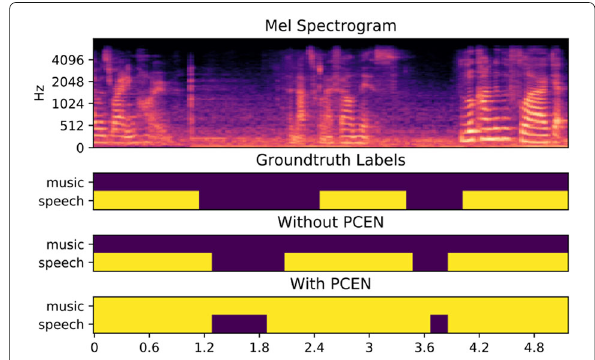
Fig. 4 An example selected from TVSM-test where PCEN fails. The figure shows the detection of background ambient sound with or without PCEN in a 5-s segment. Yellow regions indicate active labels while purple regions stand for inactive